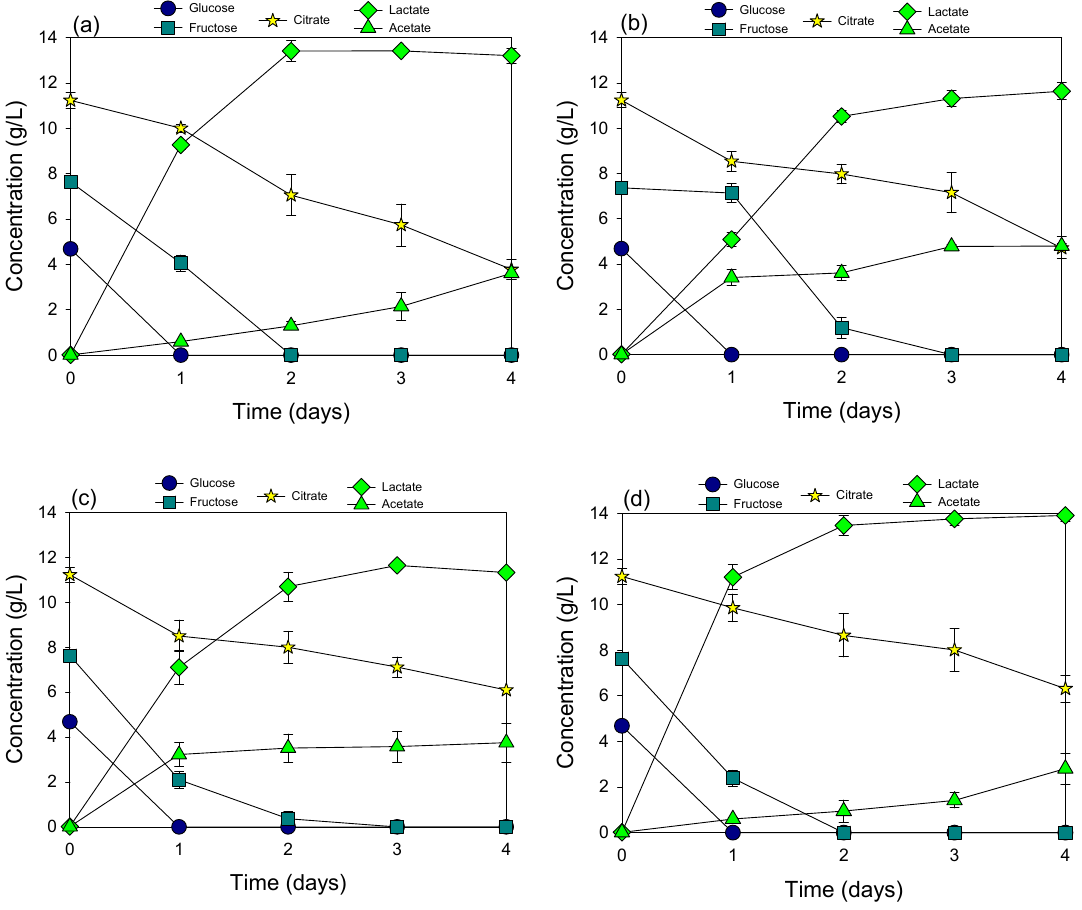
Figure 3. Fermentation of cucumber extract neutralized by HMC using Lactobacillus plantarum ( a ), Pediococcus acidilactici ( b ), Lactobacillus casei KCTC 13086 ( c ), and Lactobacillus paracasei KCTC 13169 ( d ).